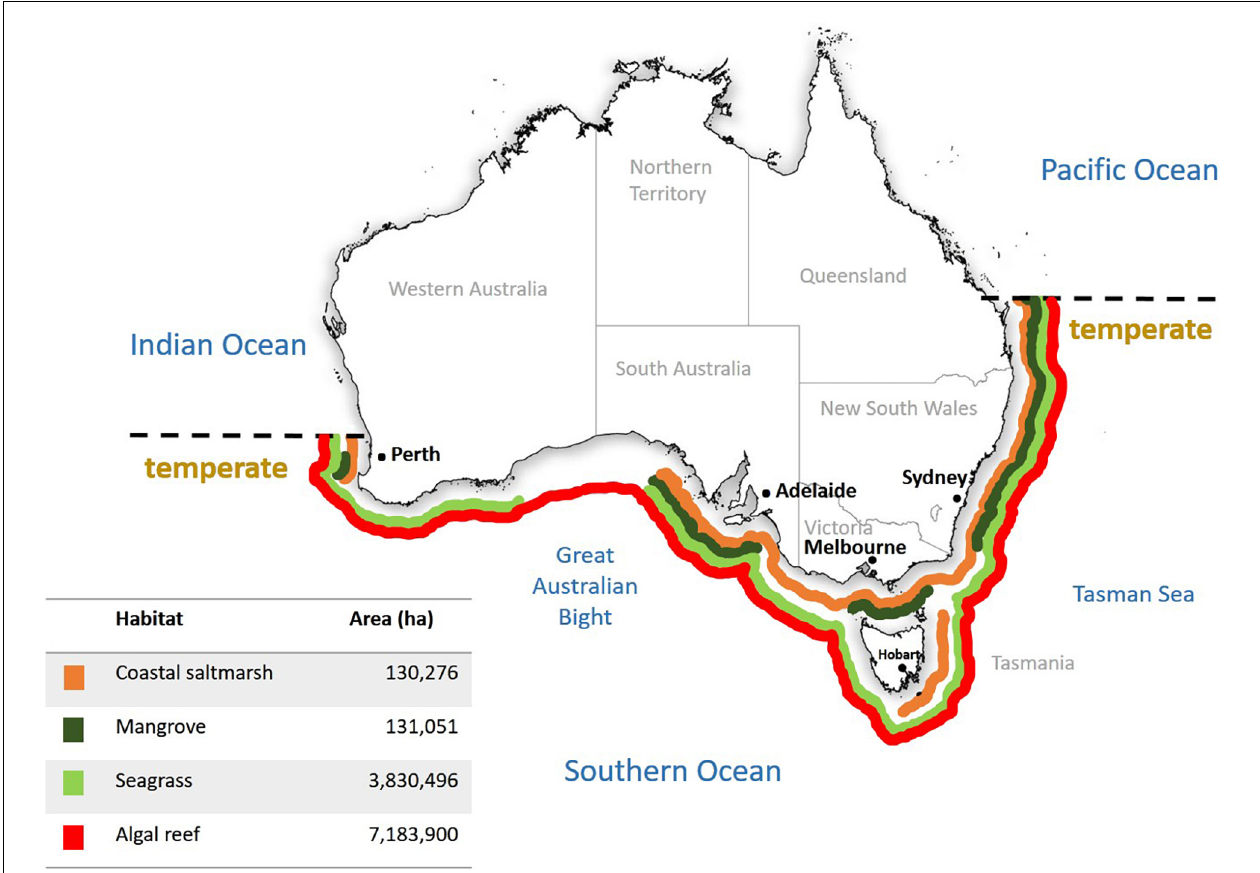
FIGURE 1 | Temperate extent of major coastal habitats indicated by solid concentric lines parallel to the coast. Dashed lines indicate the extent of temperate climatic conditions included in this review, it is acknowledged that VCE exist north of the dashed line but have not been considered in this review and as such are not included in this figure. Habitat areas are outlined in Supplementary Information S1